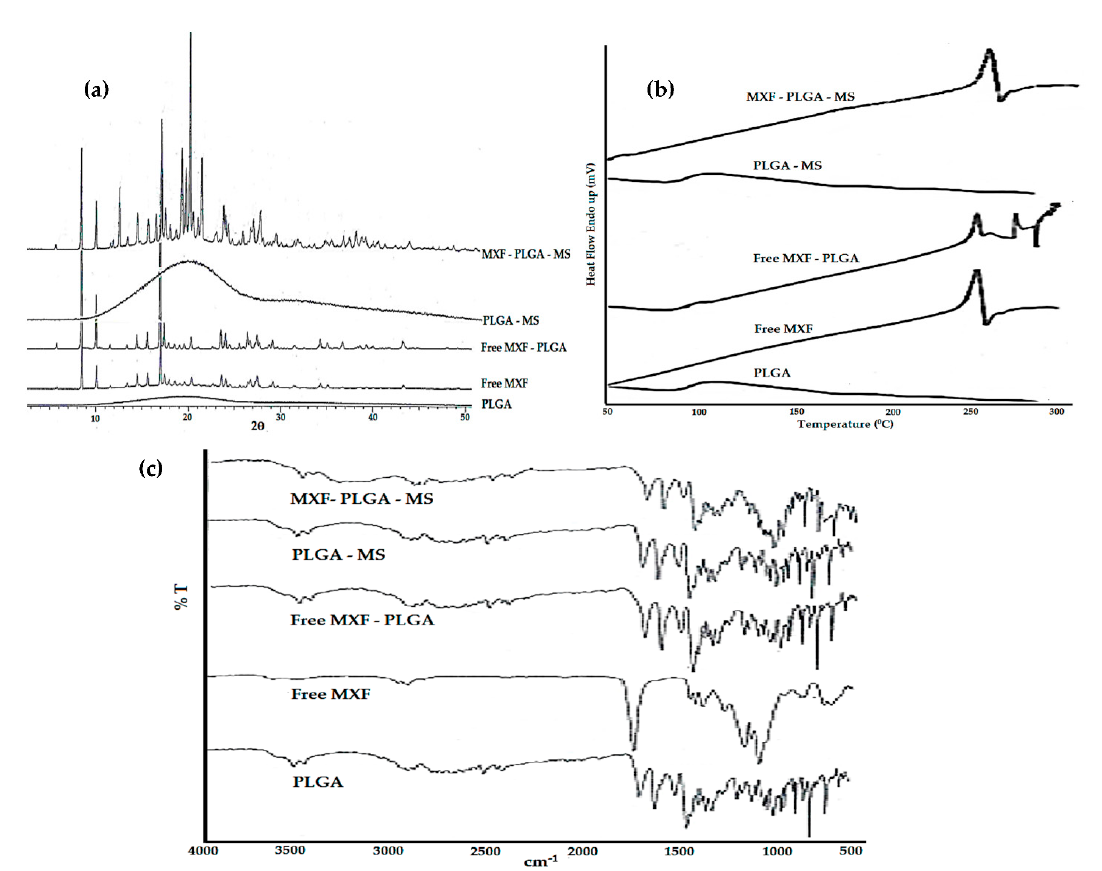
Figure 3. Physicochemical characterization/drug–polymer interaction studies. ( a ) X-ray diffraction spectra, ( b ) differential scanning calorimetry thermograms, ( c ) Fourier transform infrared spectra.